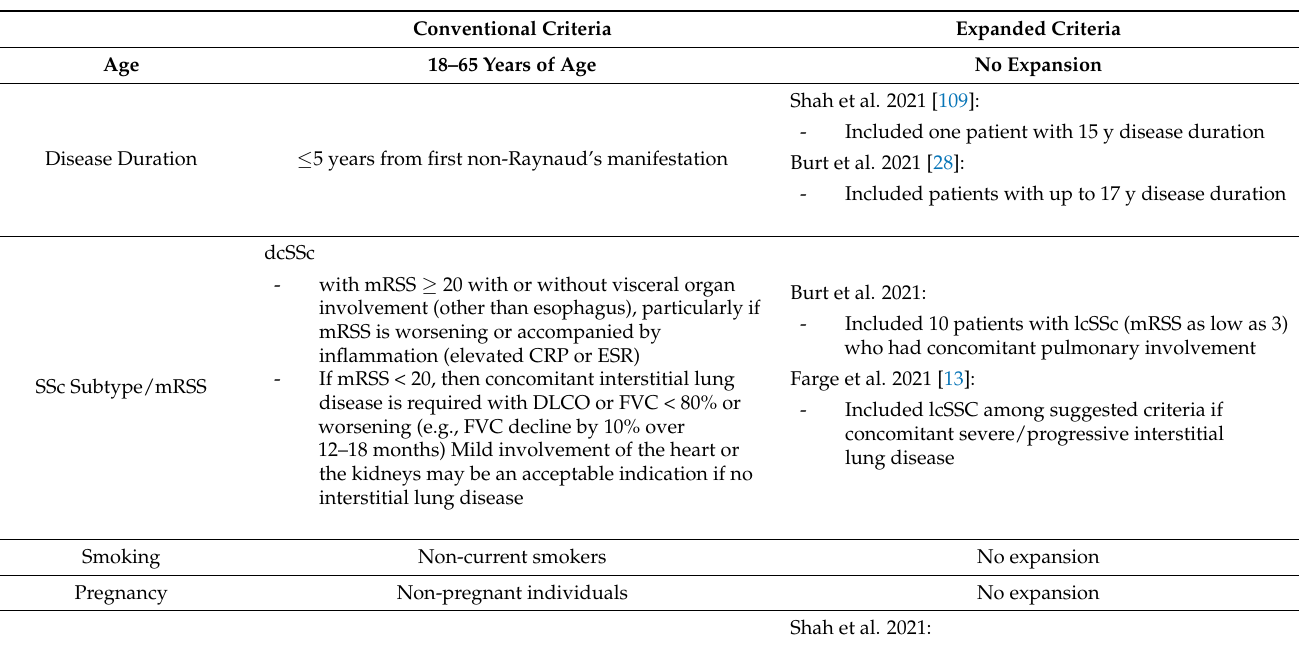
Table 2. Selection criteria for HCT, including conventionally accepted criteria for transplant, and studies exploring expanded